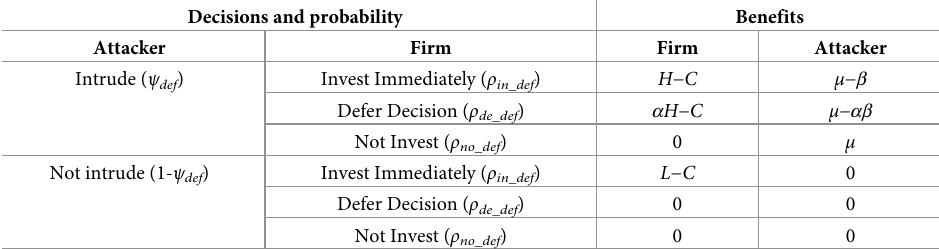
Table 2. Firm’s and attacker’s decisions and the relevant benefits when the deferral option is considered. Decisions and